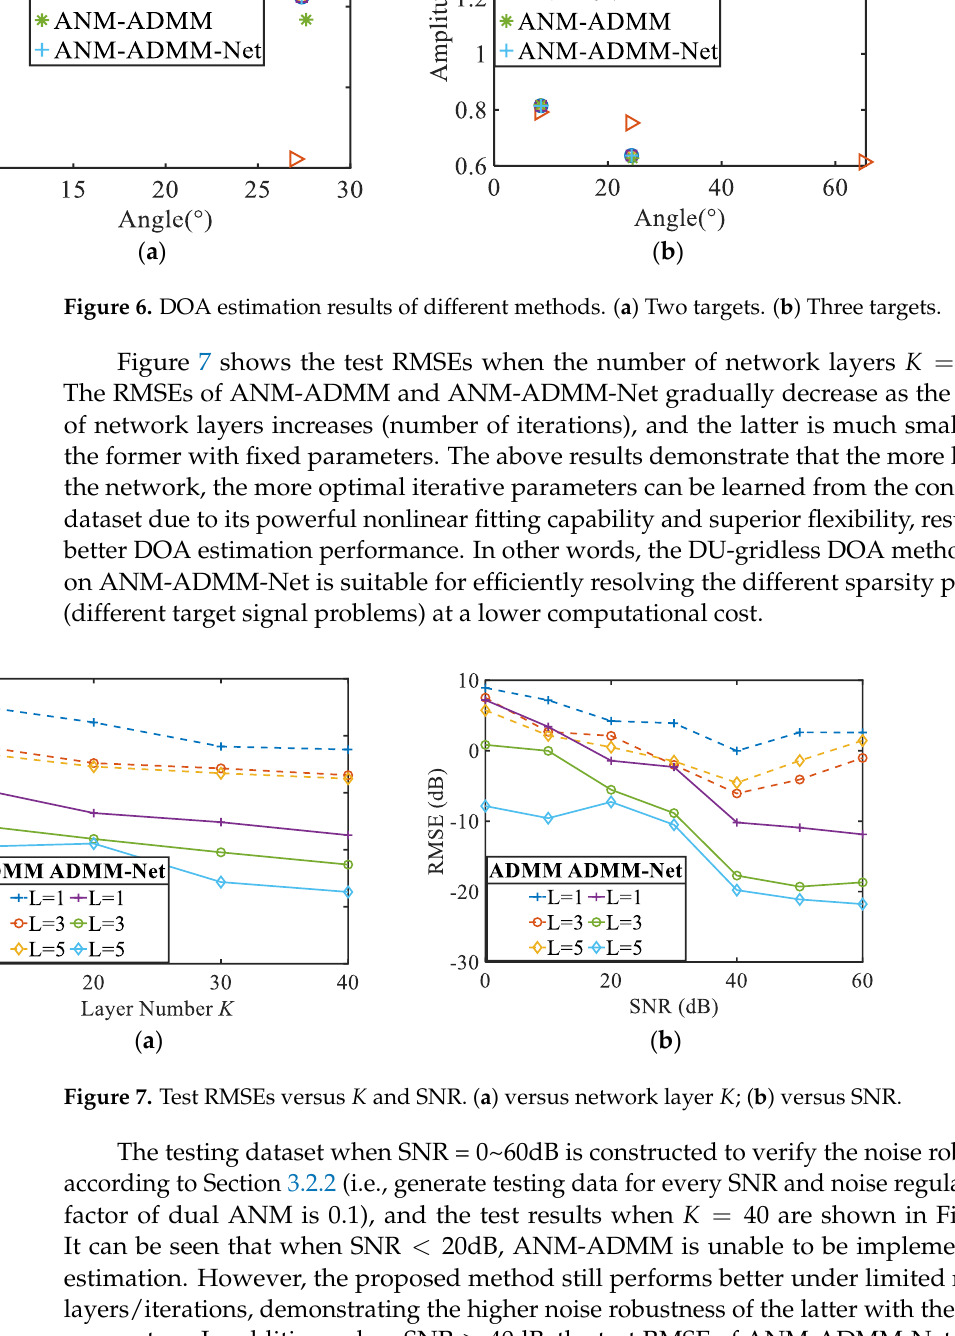
are shown in 40 K =